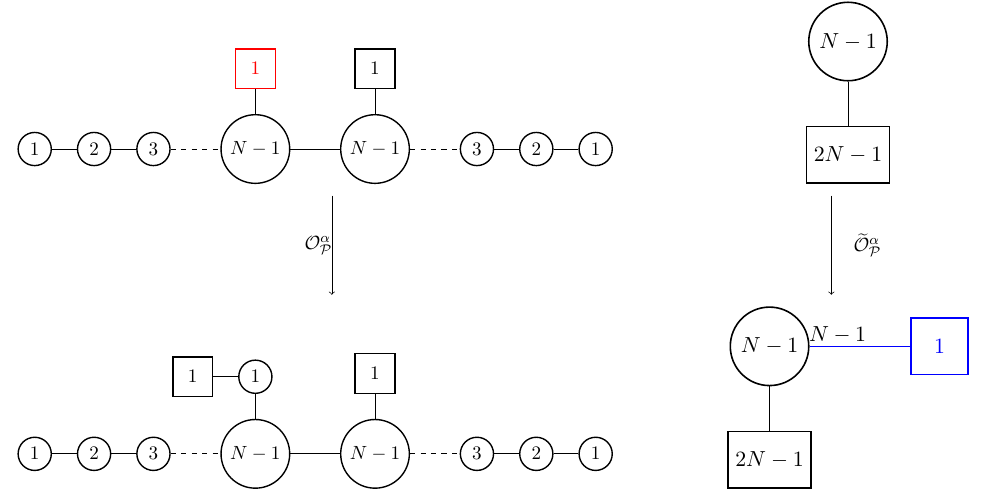
Figure 18 . The construction of the 3d mirror for T ∨ in figure 17. The S -type operation O P is a flavoring-gauging operation. The dual operation e O charged under the U(1) ⊂ U( N − 1) gauge group with charge N − 1